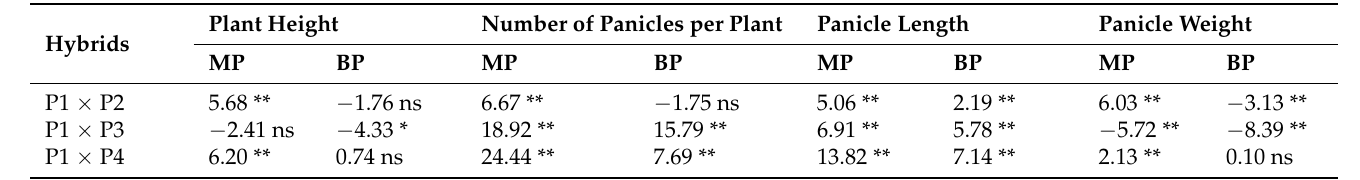
Table 2. Mid-parent heterosis (MPH) and better-parent heterosis (BPH) for 28 F 1 hybrids from half-diallel analysis of agronomic traits under drought